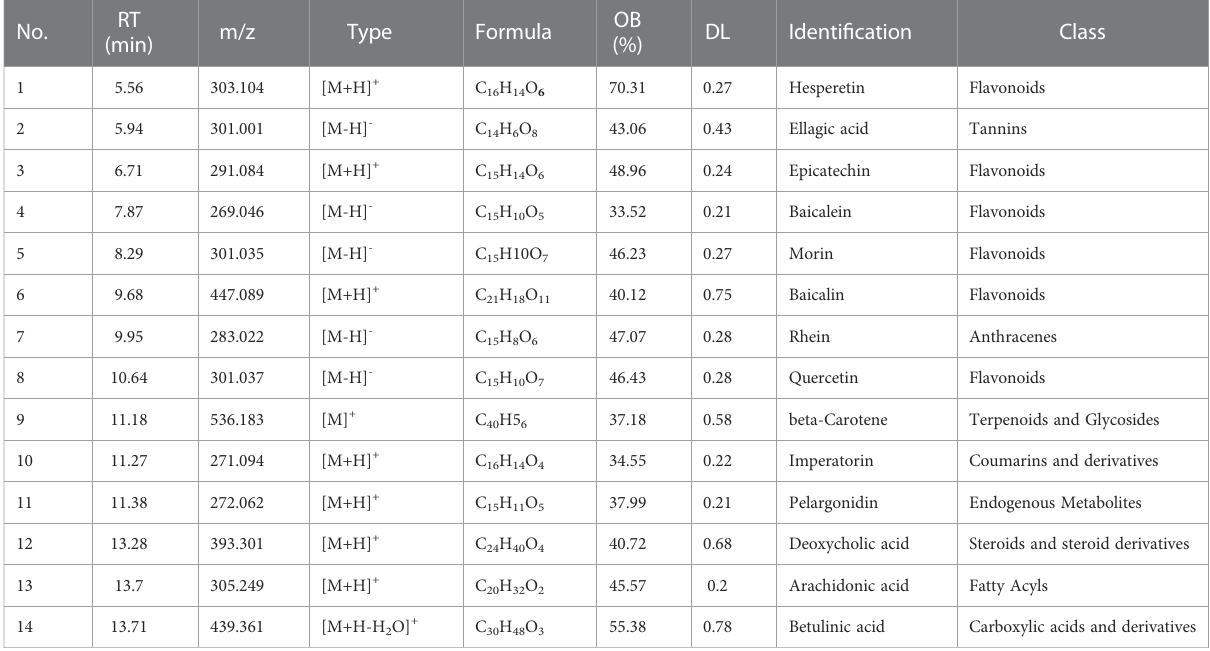
TABLE 1 Characterization of chemical constituents of Inonotus obliquus .